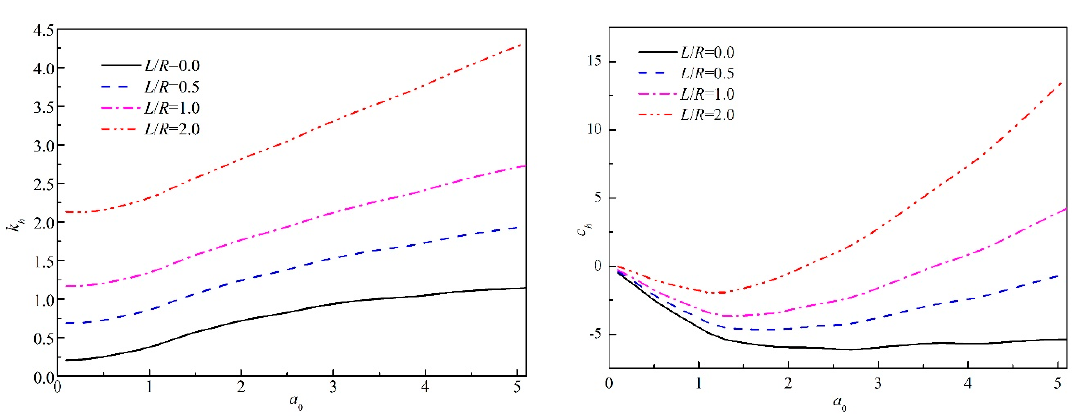
Figure 4 . Horizontal dynamic impedance of embedded foundation under different embedment ratio.